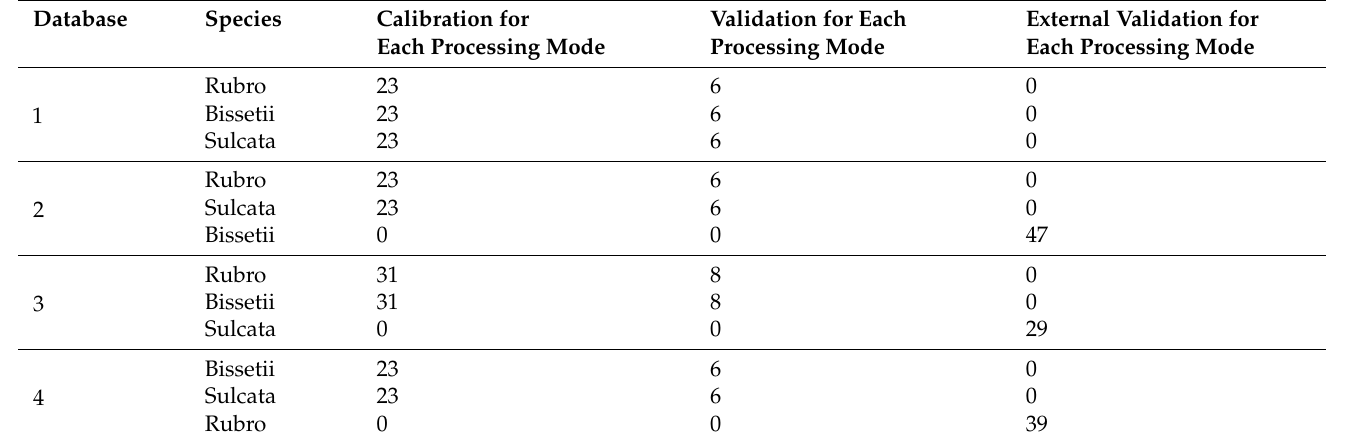
Table 1. Balanced databases containing NIR spectra collected from each bamboo species under each processing mode. Databases 2–4 are generated using spectra from two bamboo species and the calibration models were tested on spectra collected from the third bamboo